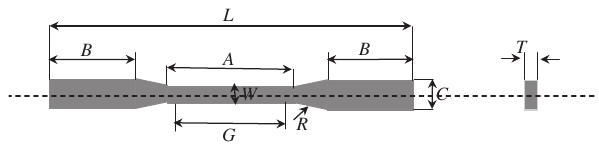
Figure 1: Schematic of subsize specimen for tensile test.